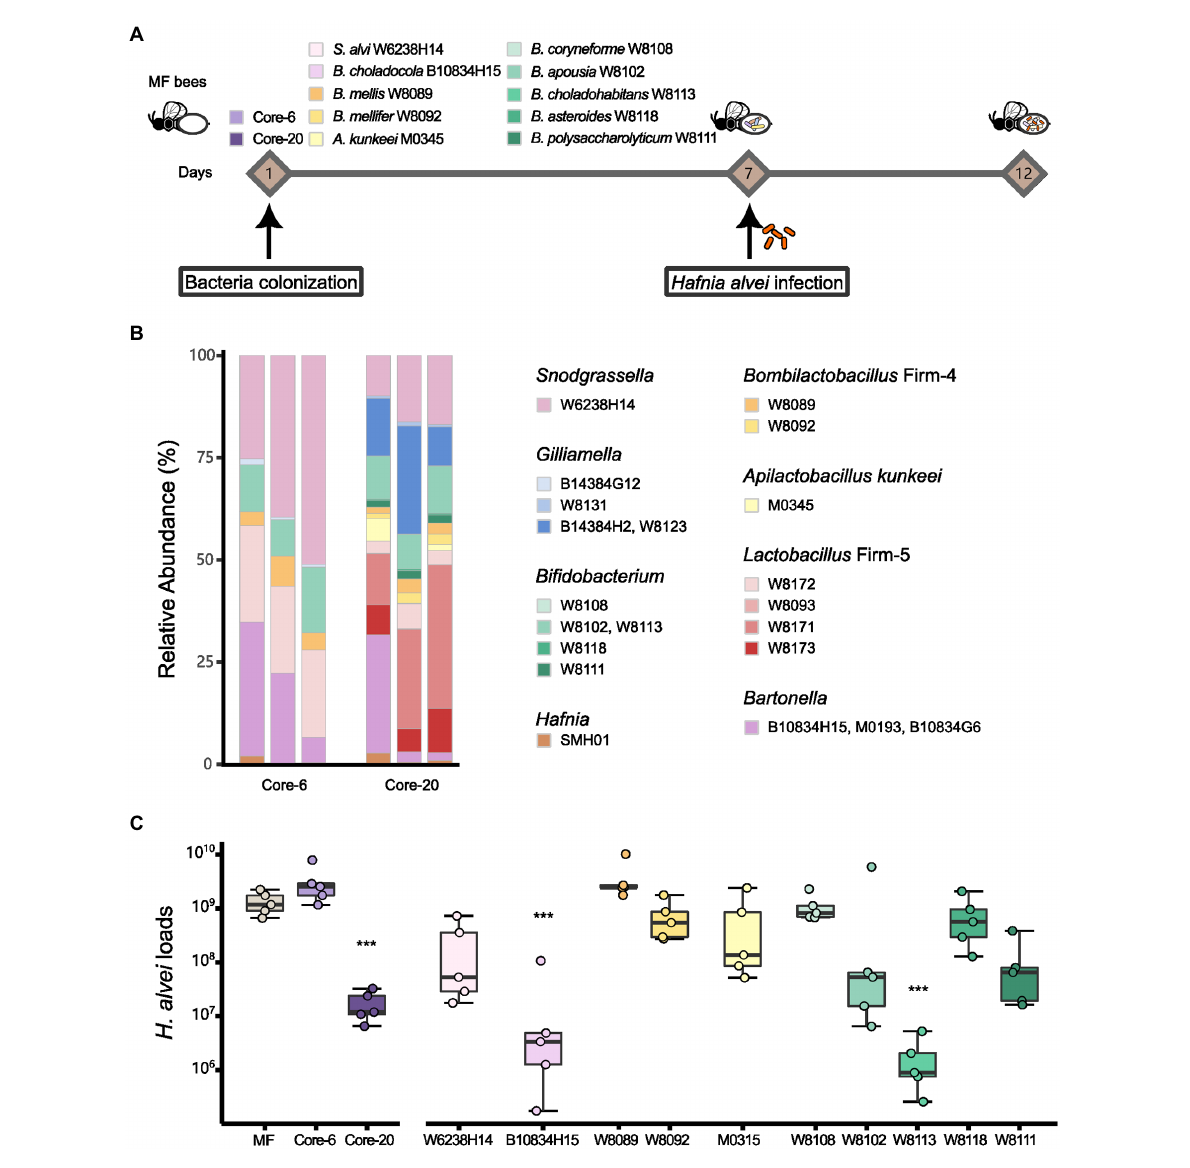
FIGURE 2 Core-20 leads to protection against oral H. alvei infection. (A) Experimental design for honeybees colonized with specific microbes challenging with H. alvei . (B) Relative abundance of the Core-6 and Core-20 community on Day 12. 16S rRNA V3-V4 amplicons were sequenced and analyzed, showing successful microbiota colonization and composition differences between the Core-6 and the Core-20. (C) Absolute abundance of H. alvei in different treatment groups 5 days post-infection. Single strains, such as B. choladocola B10834H15 and B. choladohabitans W8113, significantly inhibited the growth of H. alvei . The Core-20 community, which is much more complex than the Core-6, significantly reduced the H. alvei